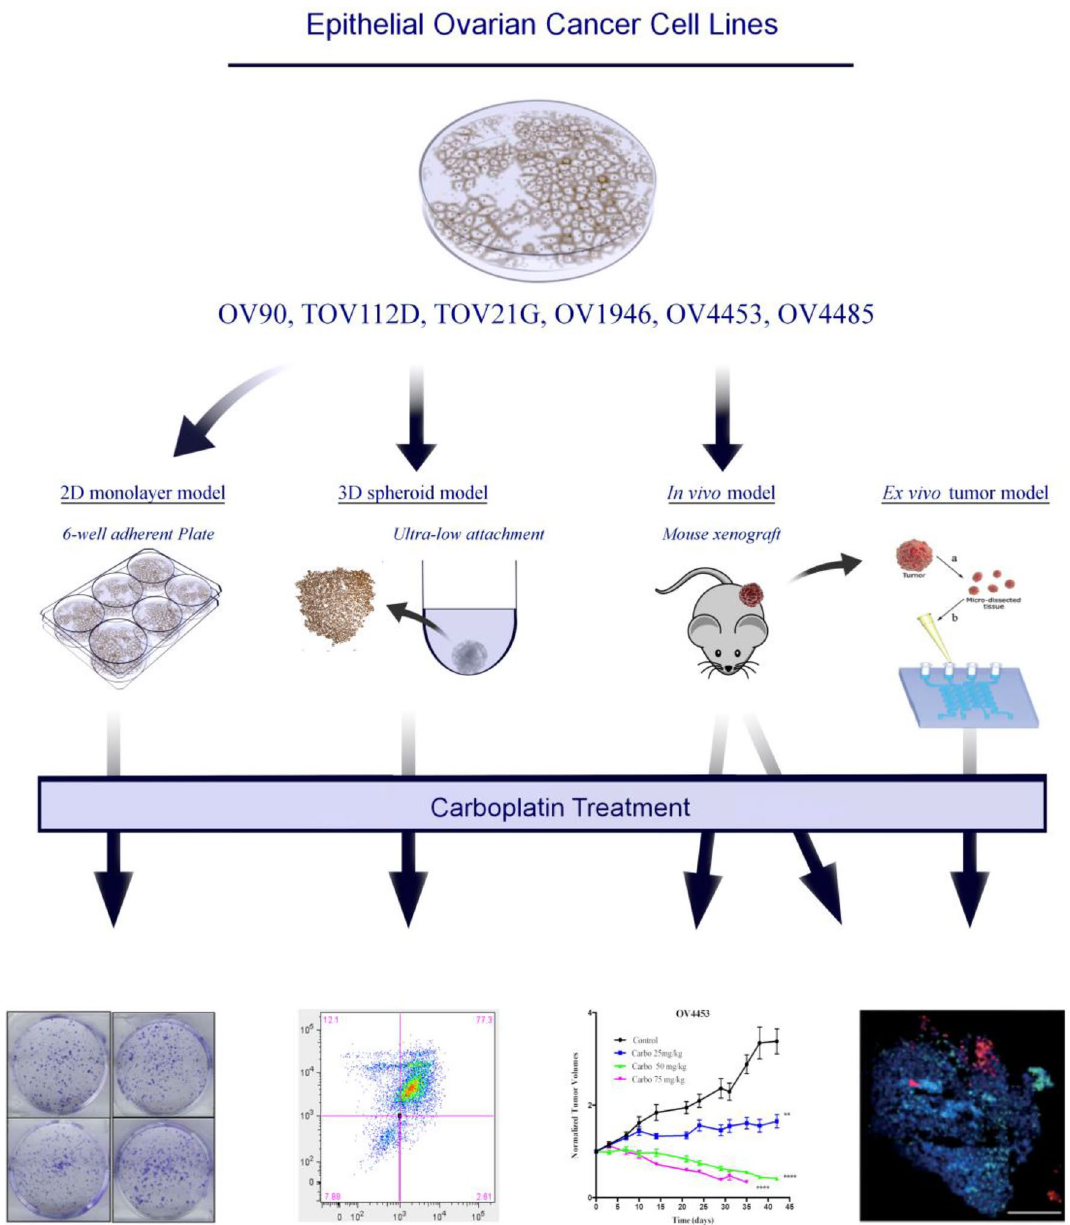
Figure 1. Schematic illustration of study design. Carboplatin chemotherapy response of six EOC cell lines was compared under different model systems: 2D monolayers, 3D spheroids, ex vivo MDTs of tumors, and in vivo xenograft mouse model. Using ultra-low attachment plates, 3D spheroids were treated and analyzed by flow cytometry. Cell lines were injected in immunodeficient mice for xenograft formation and analyzed for tumor volume curves and immunofluorescence. Control xenografts from five cell lines were used for ex vivo tumor generation and placed in microfluidics devices for treatment and analysis by